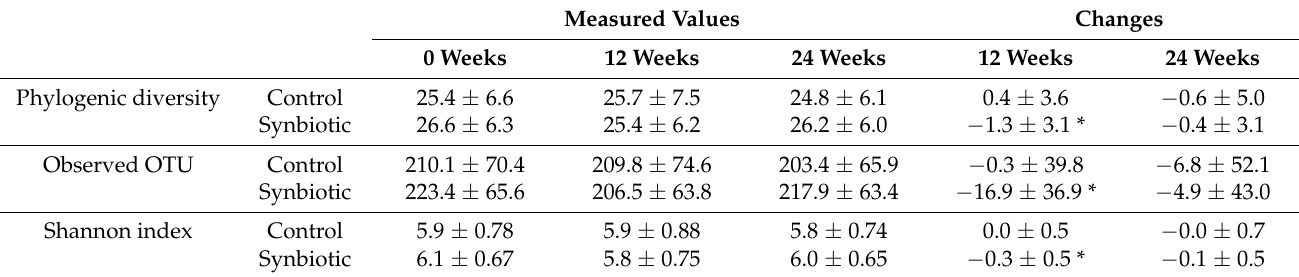
Table 5. Serial changes in microbial diversity in the control and synbiotic